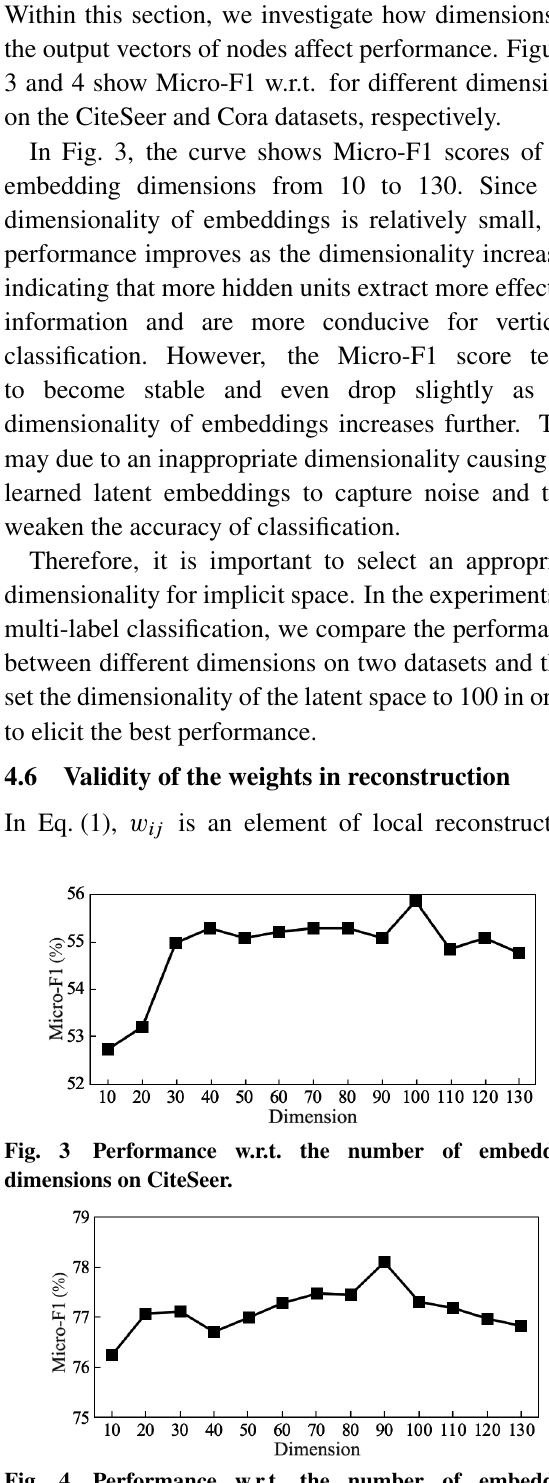
Fig. 6 Validity of the weights on